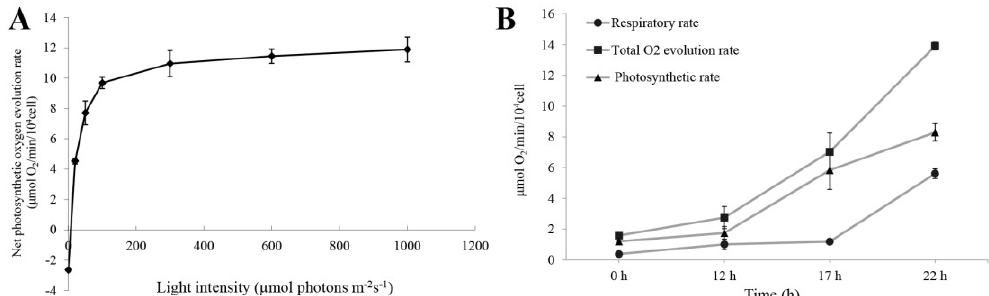
Figure 2. ( A ) Light response curve for net photosynthetic O 2 evolution rate of H. pluvialis cells. ( B ) The respiration rate, net photosynthetic O 2 evolution rate, and total photosynthetic O 2 evolution rate during H. pluvialis non-motile cell germination. Mean ± SE of five replicates were presented.